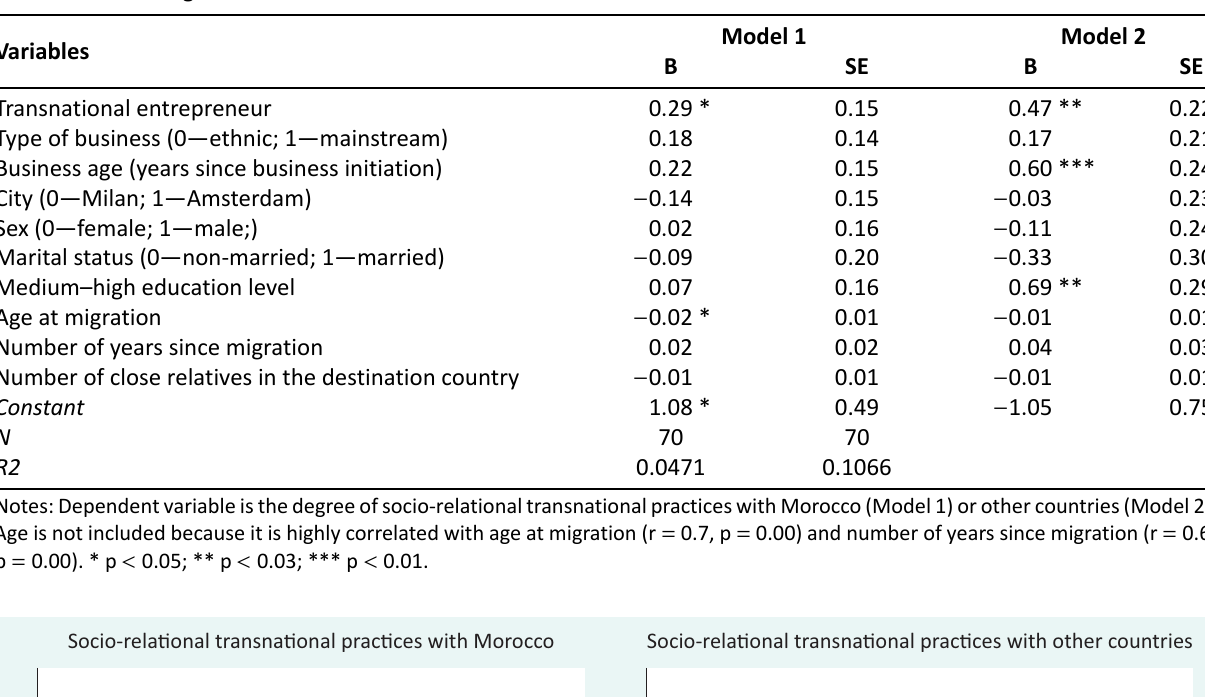
Table 2. Poisson regressions.